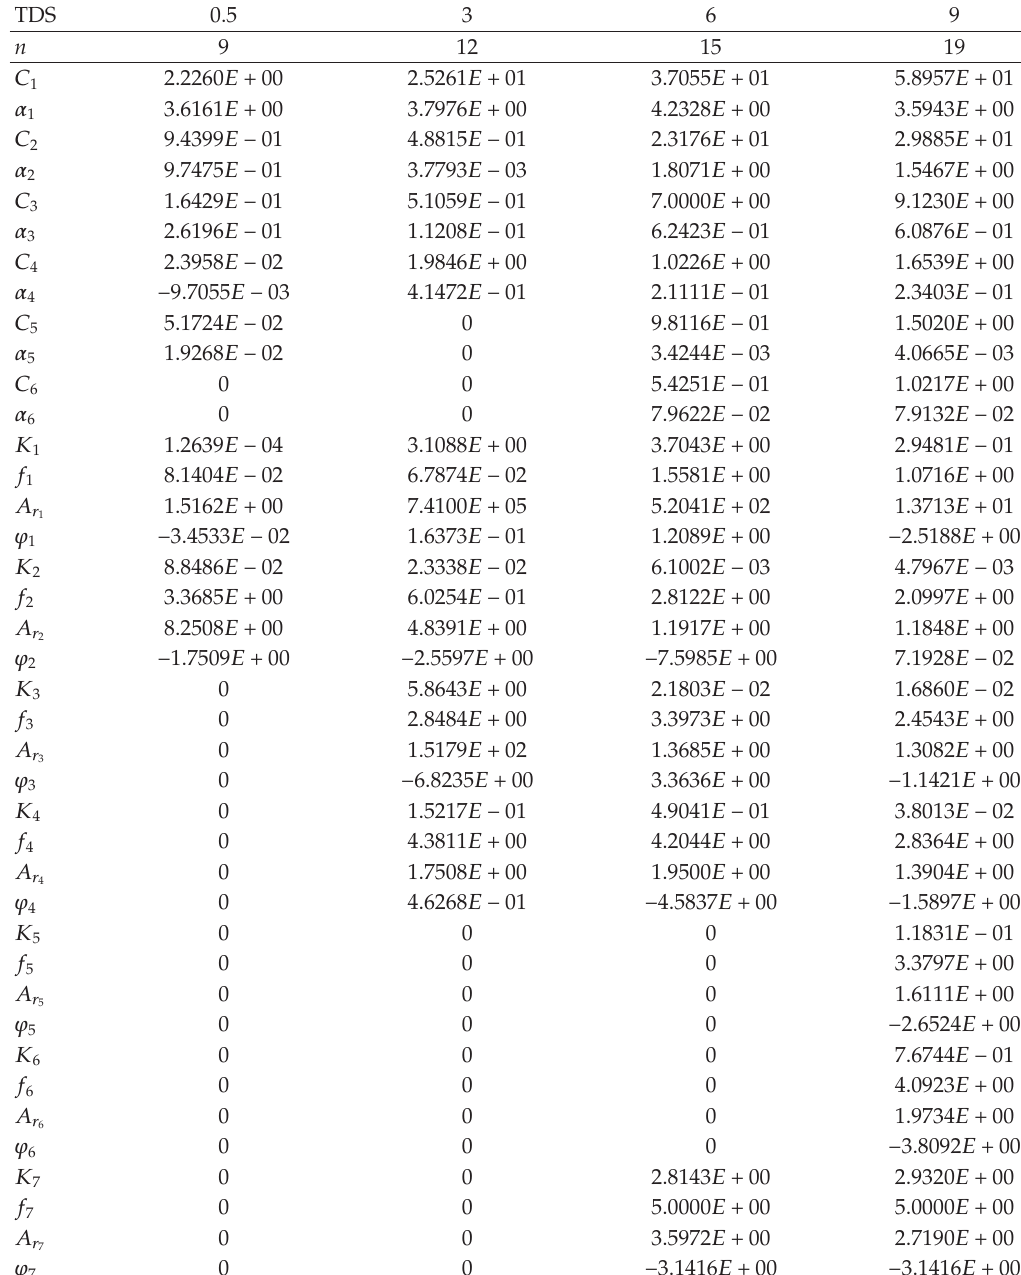
Table 4: The 40 parameters in (cid:3) 4.2 (cid:4) for the CO-8 relay.